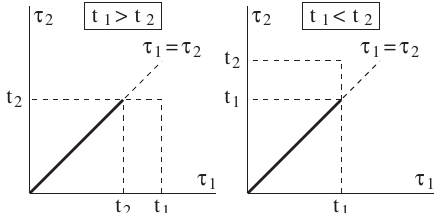
FIG. 15. Domain of